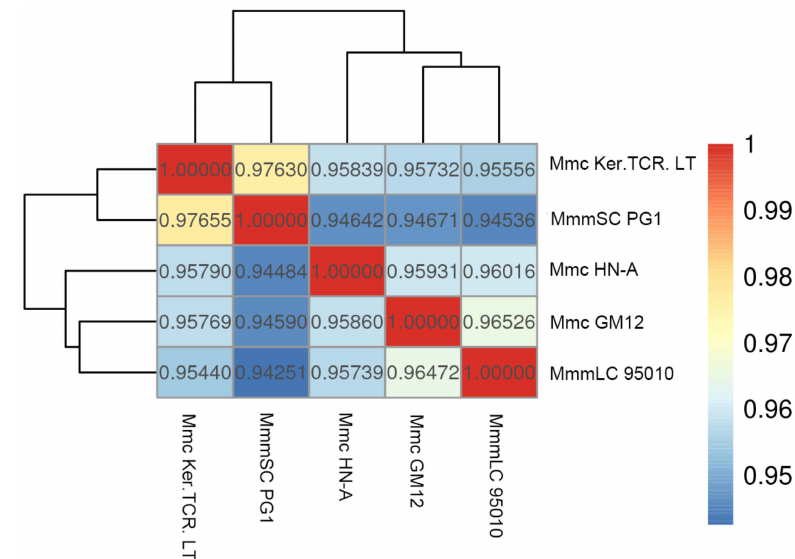
Figure 8. ANI Analysis